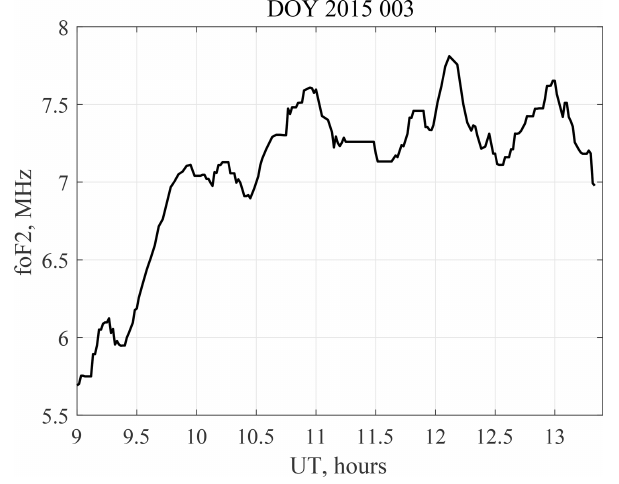
Figure 2. Variation of fo F2 frequency during 4.5h on day 2015 003, obtained with Eq.